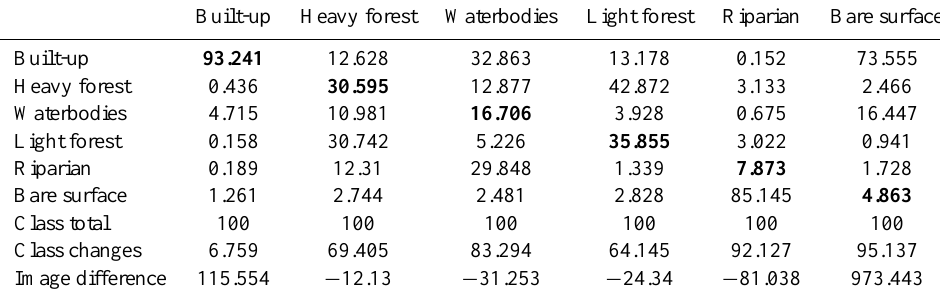
Table 5. Change detection matrix between 2000 and 2013 (%).